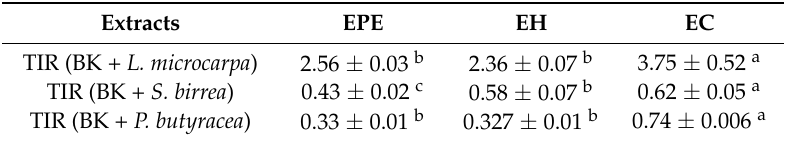
Table 1. Effects of the EPE, EH; and EC extracts on the stabilization of Shea